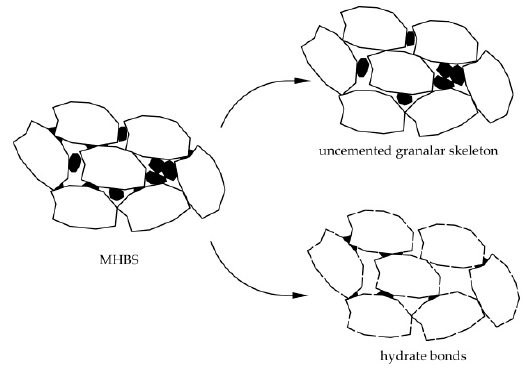
Figure 2. Schematic decomposition of the micro-structures of MHBS.